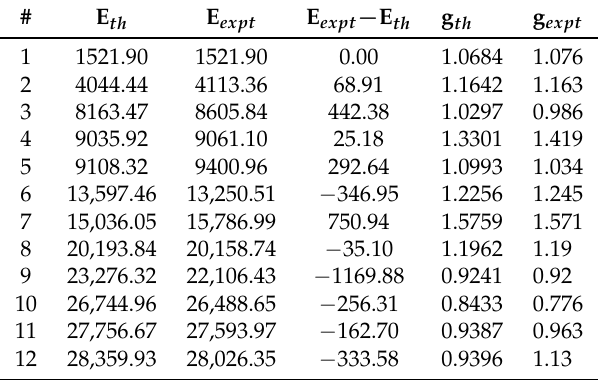
Table 5. Energies (cm − 1 ) and g-factors for optimized parameters presented in Table 1 for J = 2.5 even states. The experimental energies and g-factors are taken from NIST database